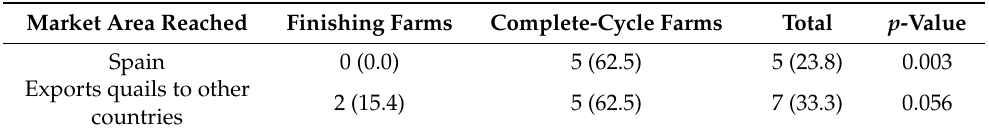
Table 8. Frequency (n, and % between parentheses) of market geographical areas reached by quail game farms, depending on farm type (n = 21).